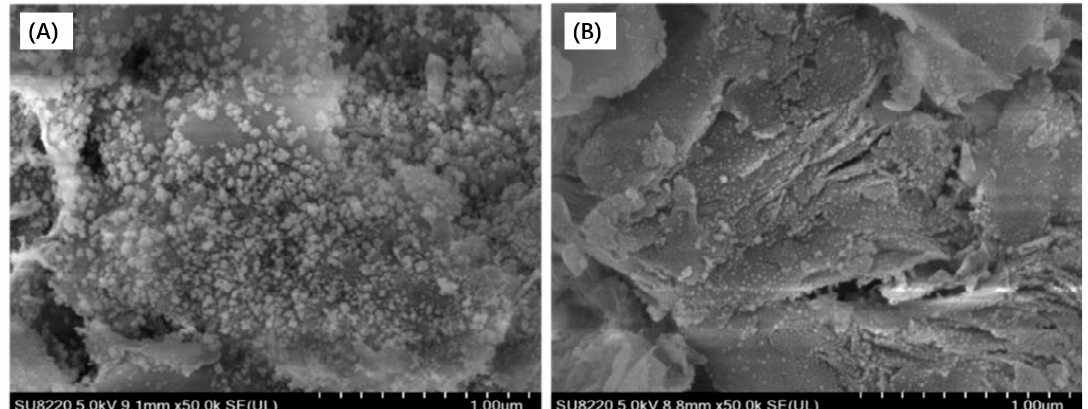
Figure 10. XRD patterns of Ni/bentonite-U ( a ) Ni-2wt%Mn/bentonite-U ( b ) catalysed after the 150-h reaction.